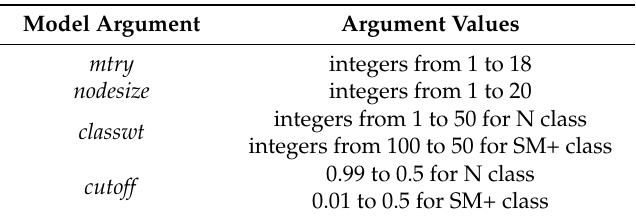
Table 1. Optimized arguments and values in randomForest package during exploratory and predictive random forests model